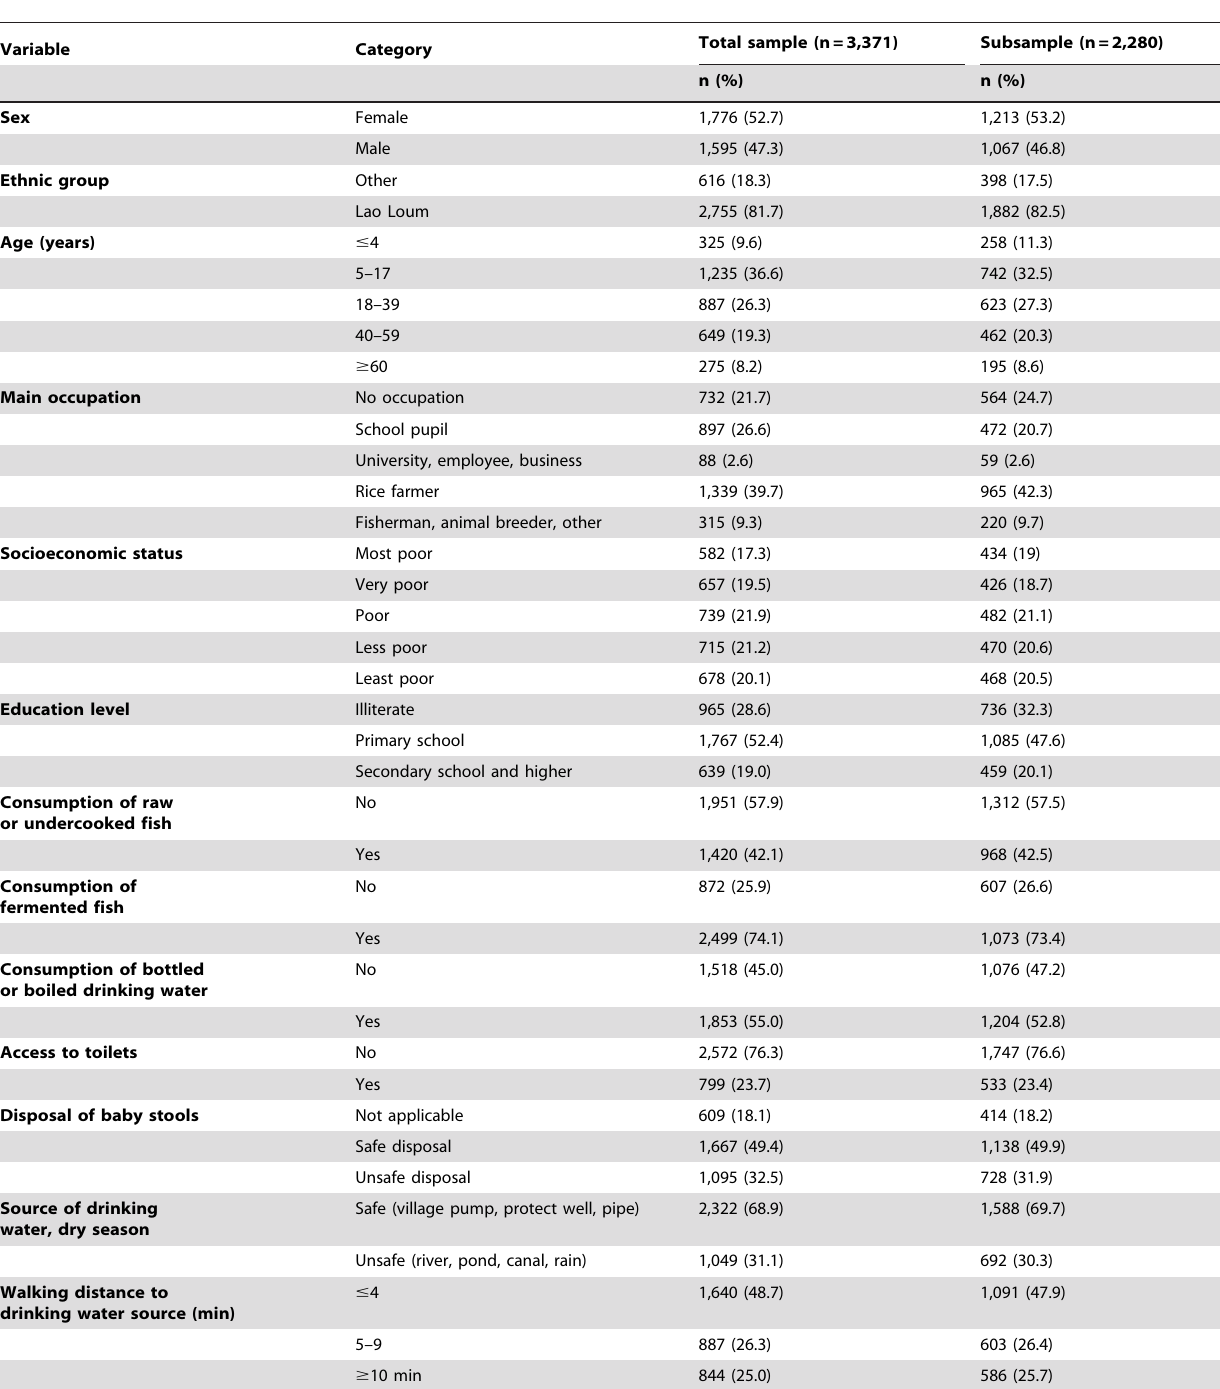
Table 1. Characteristics of total sample and subsample (after adjustment for praziquantel treatment history).